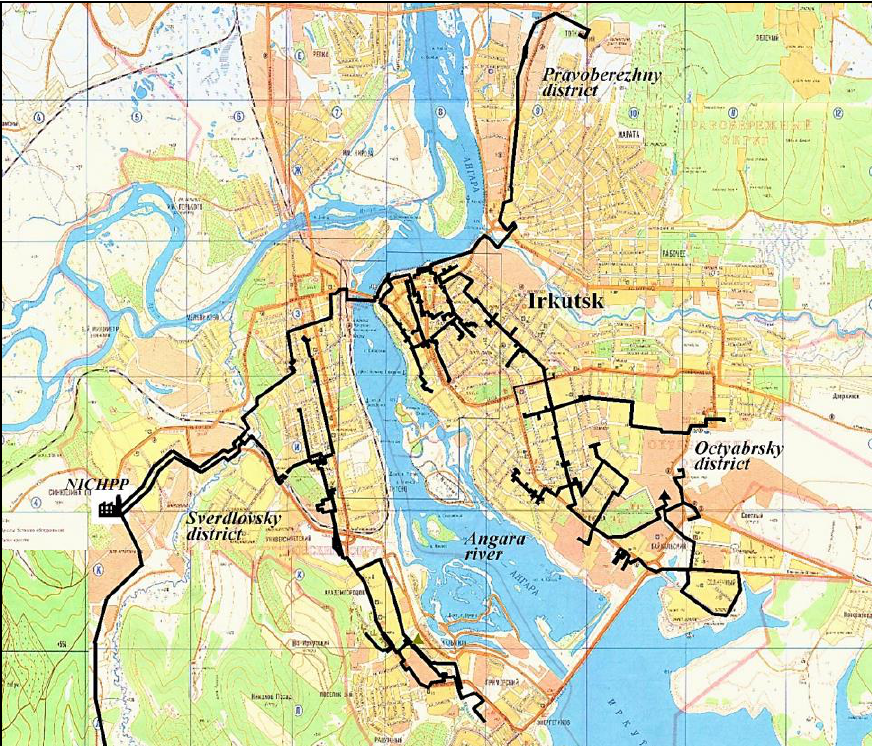
Fig. 1. DHS of Irkutsk on the city